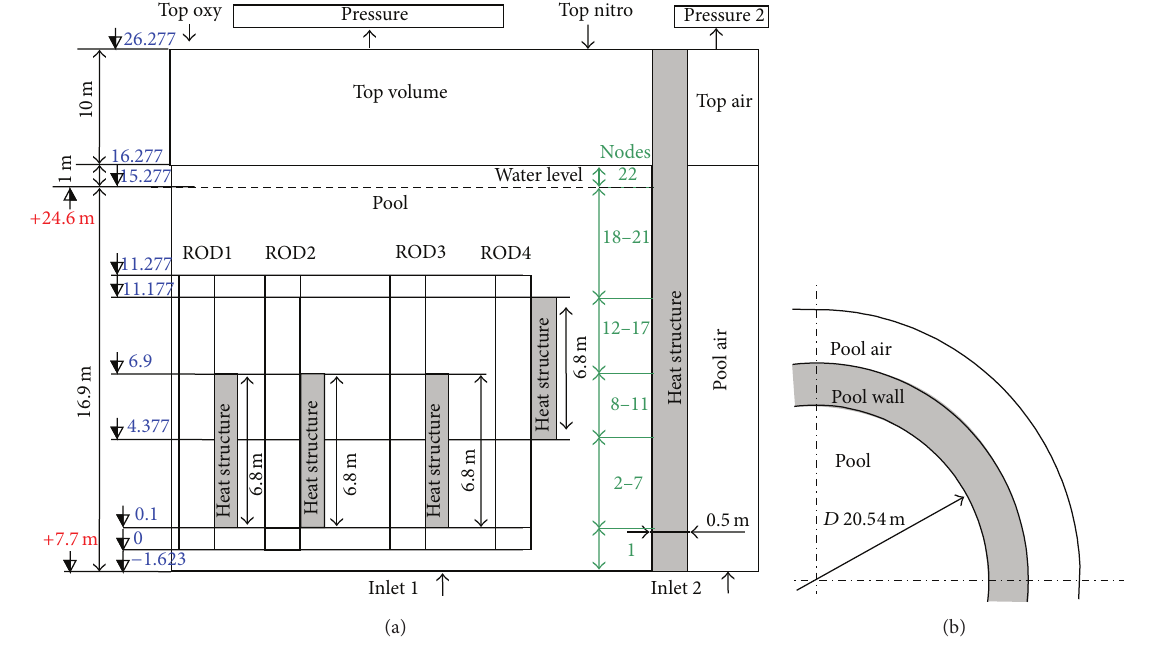
Figure 3: SFP and SFAs nodalization scheme in ATHLET-CD model. Table 2: Comparison of SFP models for three different